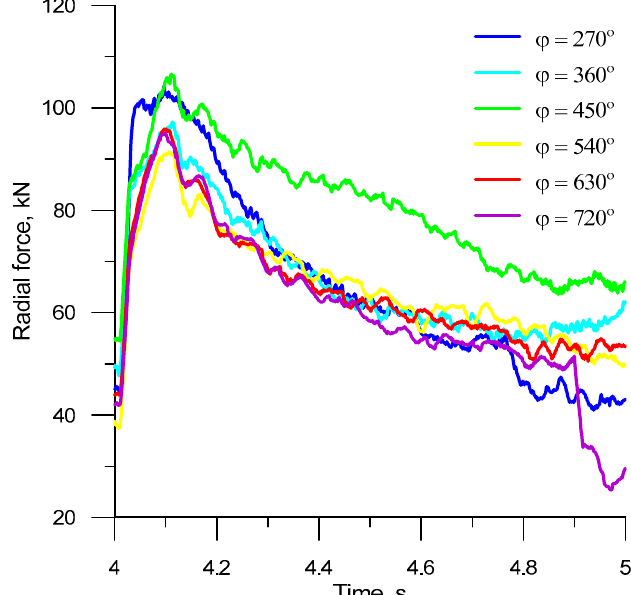
Figure 14. Radial force during the fifth revolution of the tool.